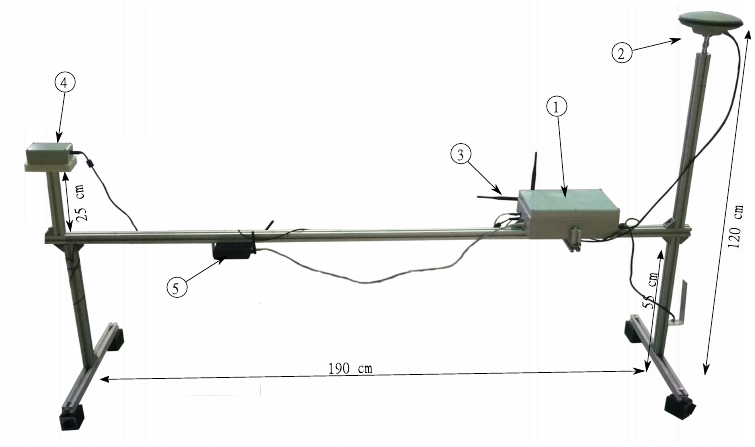
Figure 4. Landing pad navigation station, 1 (cid:13) —a main computer, 2 (cid:13) —a GNSS module with antenna,